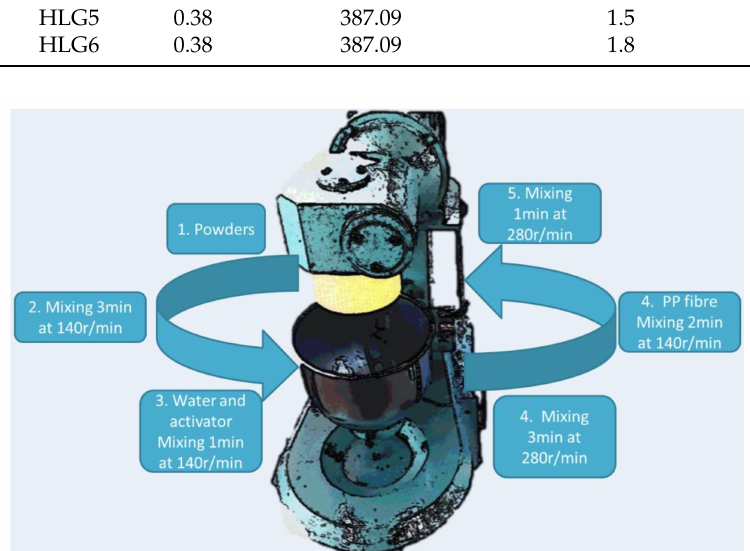
Figure 1. Mixing procedure of fibre-reinforced geopolymer paste. The specimens were demoulded 24 h after casting and were kept in a standard curing room with 20 ± 2 ◦ C and humidity above 95% until being tested at 28 days. Flexural test (three-point bending) and compressive test were performed according to ISO 679-2009 [38]. Compressive strength was determined by the two portions of prisms left after the flexural test. Moreover, ultrasonic test and apparent density were directly associated with the porosity of specimens, which was mainly introduced by